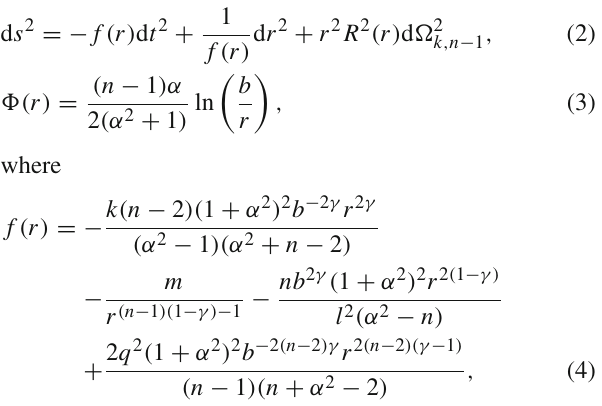
where (cid:5) is the dilaton field with its potential denoted as V ((cid:5)) . R is the Ricci scalar curvature and F μν = ∂ μ A ν − ∂ ν A μ is the electromagnetic field tensor. The strength of cou- pling between the electromagnetic field and the scalar field is characterized by α